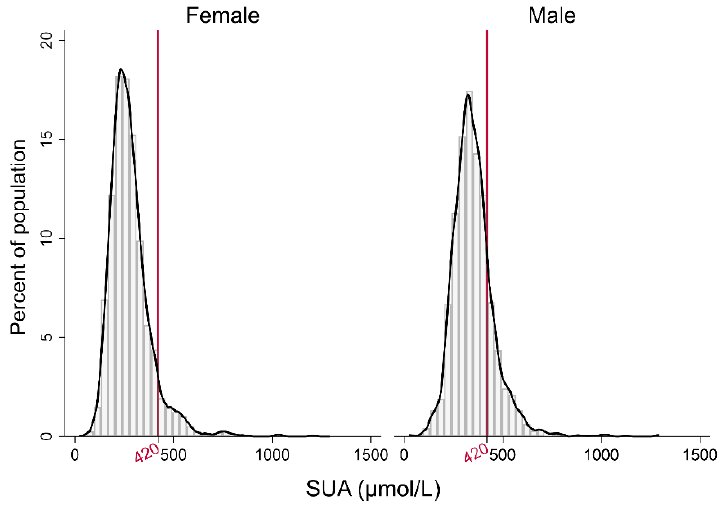
Figure 2. Distributions of SUA concentrations.